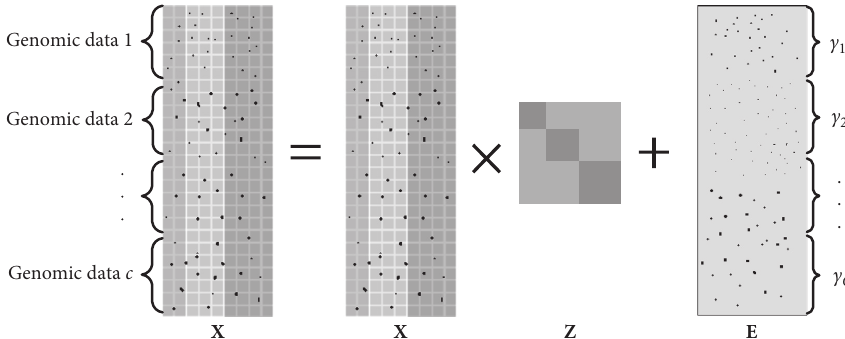
Figure 2: The schematic diagram of BLLRR decomposition of integrated multigenome